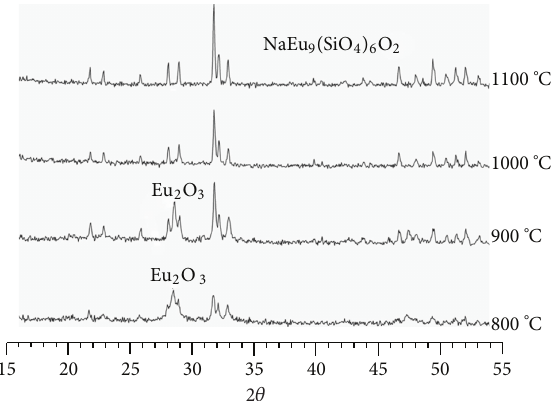
F 1: X-ray diffraction spectra for